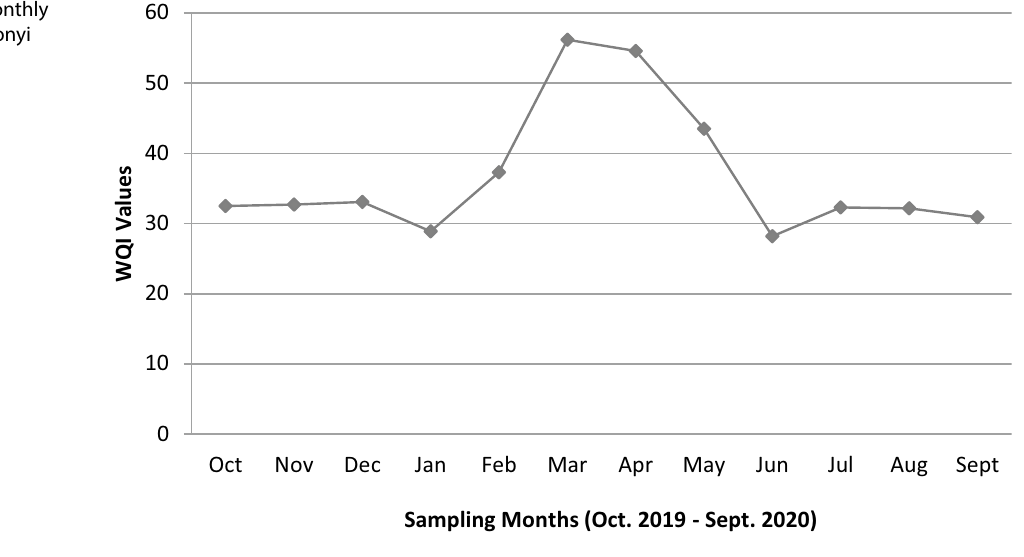
Fig. 2 Changes in the monthly WQI values at Lake